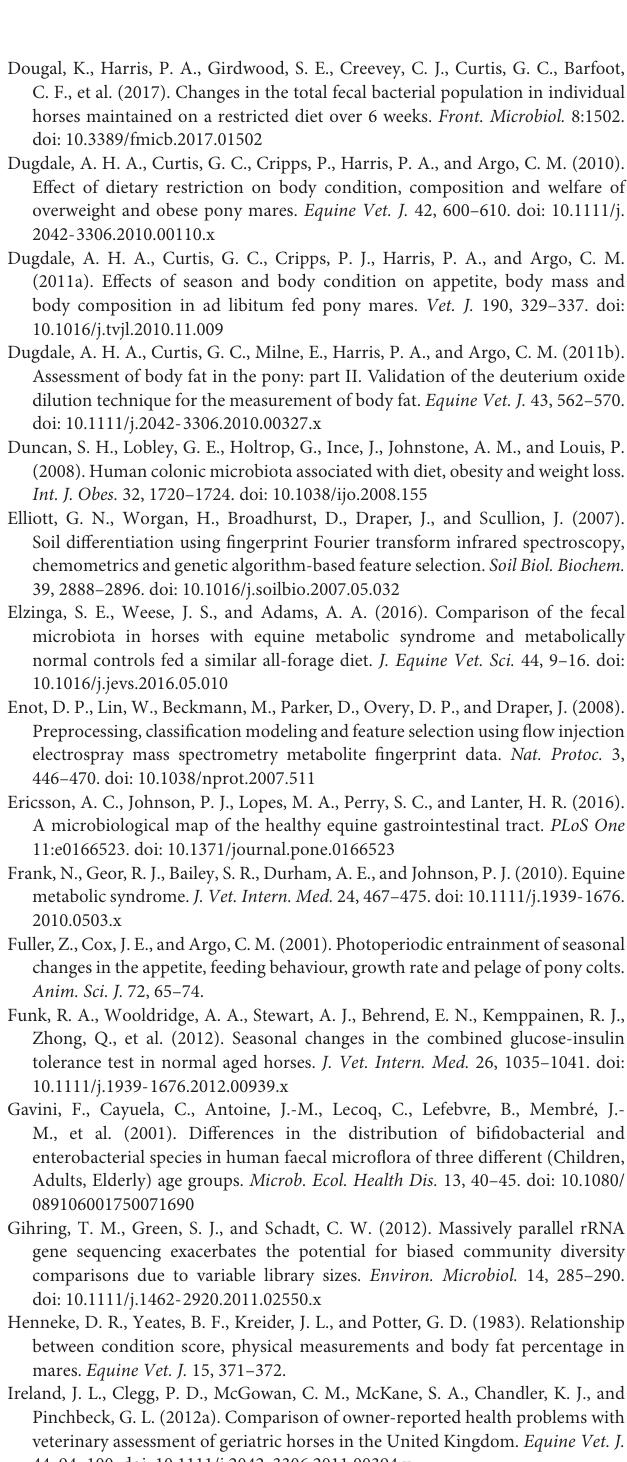
TABLE S7 | Relative abundance of bacterial OTUs significantly different in abundance between Control and Obese groups across the two years following Deseq analysis. TABLE S8 | Relative abundance of core bacterial OTUs between